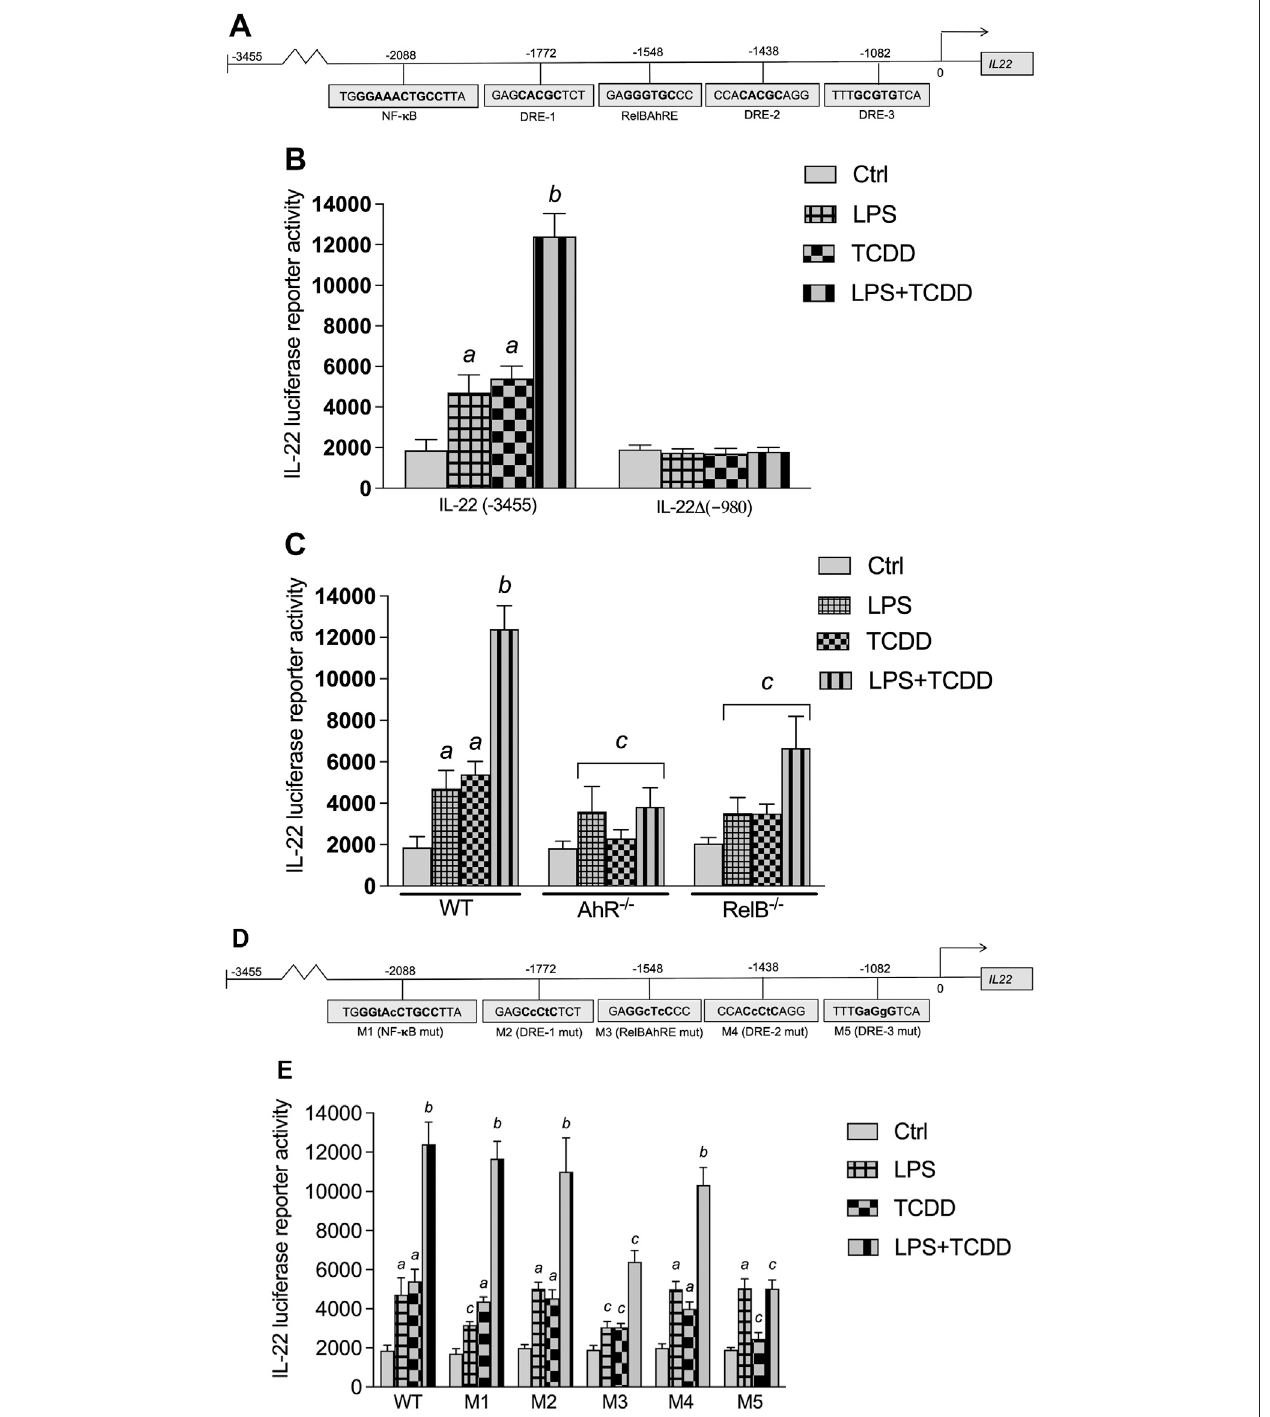
FIGURE 6 | Effect of AhR and TLR4 activation on IL-22 promoter activity. (A) Schematic illustration of the mouse IL-22 promoter containing 3,455 bp upstream of the transcriptional start site. Positions of putative DRE, RelBAhRE, and NF- κ B DNA binding sites are presented. (B) Effect of TCDD and LPS on IL-22 promoter activity. BMM derived from WT mice were transiently transfected with the full-length IL-22 or a IL-22 deletion construct containing 980 bp upstream of the start site. (C) BMM derived from WT, AhR − / − and RelB − / − mice were transiently transfected with the full-length IL-22 construct containing 3,455 bp upstream of the start site. Cells weretreated with 1 nM TCDD and 1.0 μ g/ml LPS or co-treated with LPS plus TCDD for 24 h. (D) Schematic illustration of themutated (indicated by small letters ) NF- κ B (M1), DRE-1 (M2), RelBAhRE (M3), DRE-2 (M4), and DRE-3 (M5) sites of the mouse Il22 gene. (E) Effect of LPS and TCDD on mutation constructs of the mouse IL-22